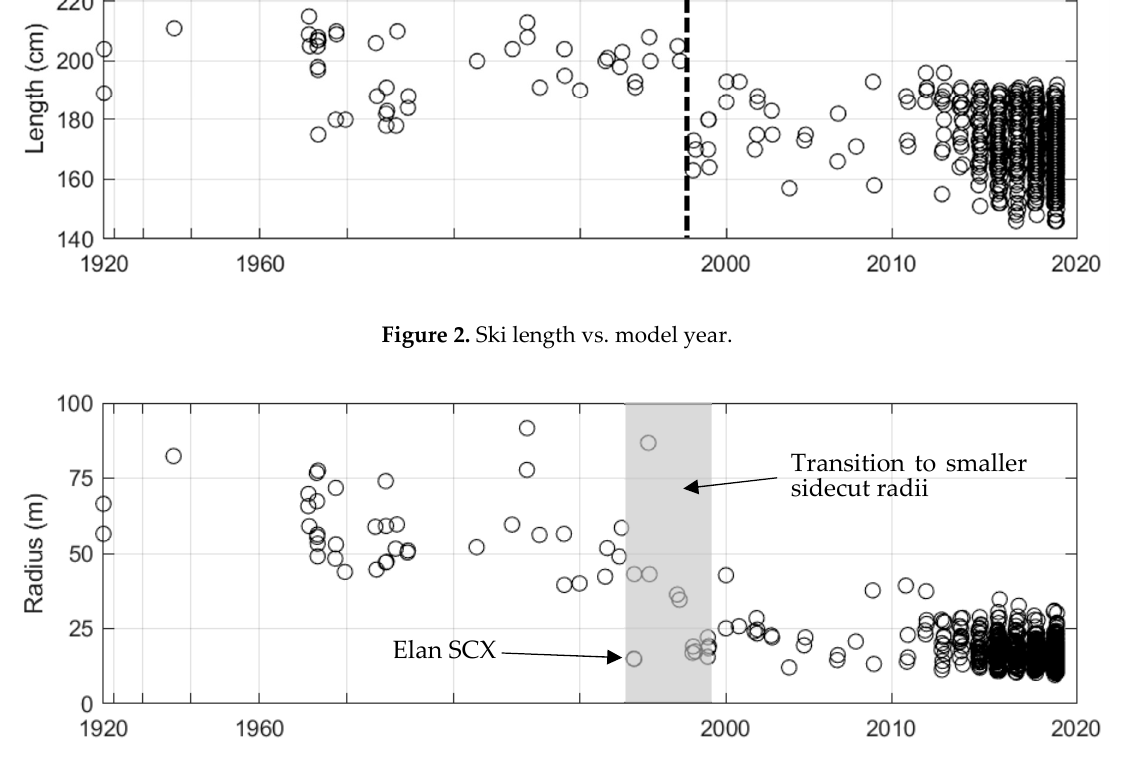
Figure 3. Sidecut radius vs. model year.